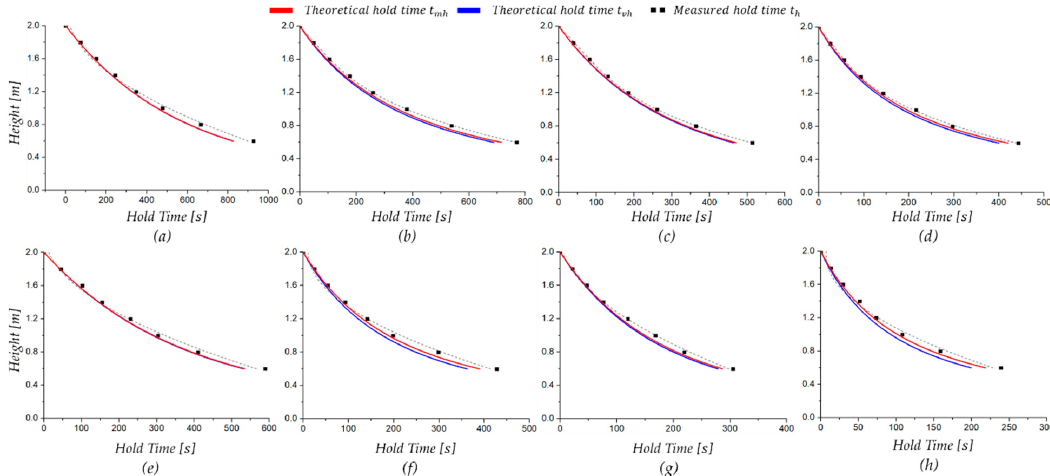
Figure 8. Change of hold time according to enclosure height for each condition. The theoretical hold time was predicted based on the wide model . The threshold concentration c th at which the hold time was determined was set to 85% of the initial concentration c mix . ( c th = 0.85 c mix ): ( a ) IG-01 , 4 holes; ( b ) IG-01 , 8 holes; ( c ) IG-01 , 12 holes; ( d ) IG-01 , 16 holes; ( e ) HFC-125 , 4 holes; ( f ) HFC-125 , 8 holes; ( g ) HFC-125 , 12 holes; and ( h ) HFC-125 , 16